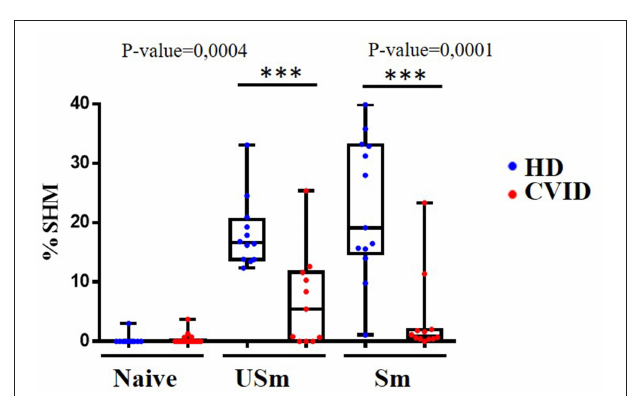
FIGURE 4 | Frequency of SHM in naïve, unswitched (USm) and switched (Sm) memory B cells in healthy donors (blue) and CVID patients (red). By definition, naïve B cell do not undergo SHM, the frequency of SHM is severely reduced in USm and Sm in CVID patients. The P -value is shown for comparisons between HD and CVID patients with a statistically significant difference by Mann-Whitney test (*** p < 0.001). Box and whiskers with minimum to